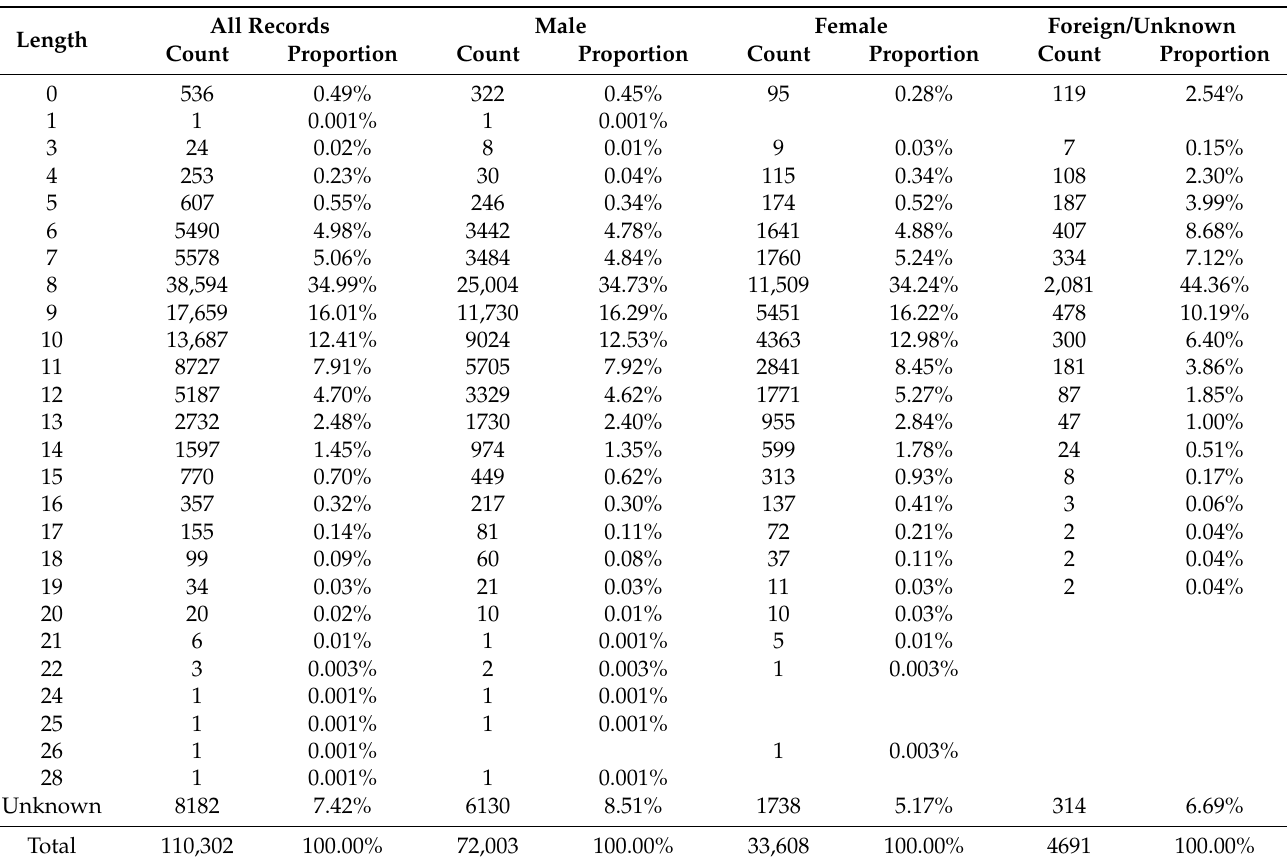
Table 2. Distribution of password lengths (all 110,302